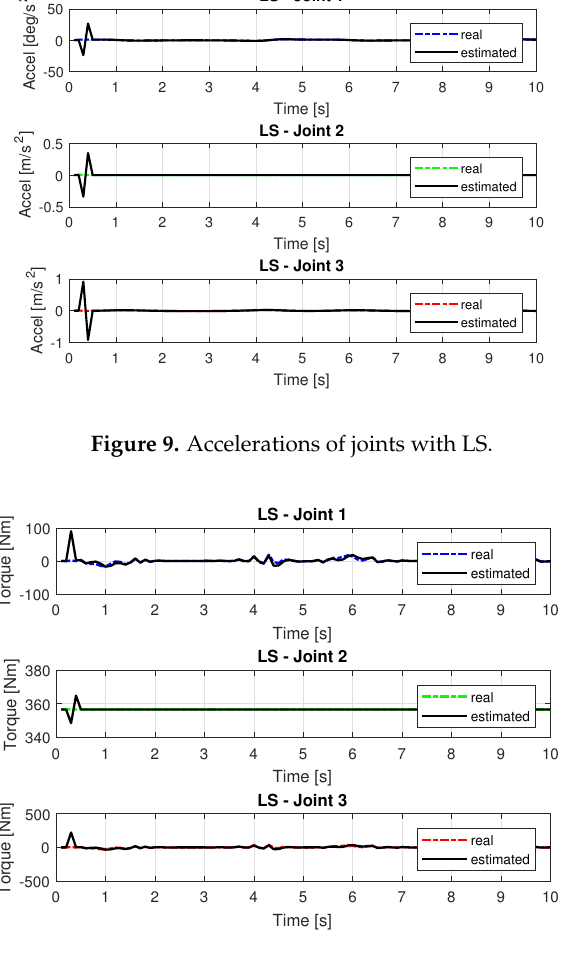
Figure 10. Torque of joints with